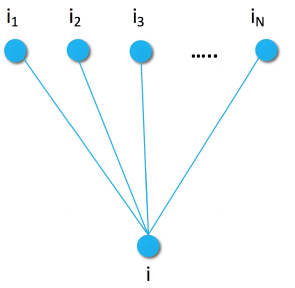
Figure 1. Similarity graph of item i with sample items S = { i 1 , i 2 ,..., i N } of distances dist ( i , i n ) from i